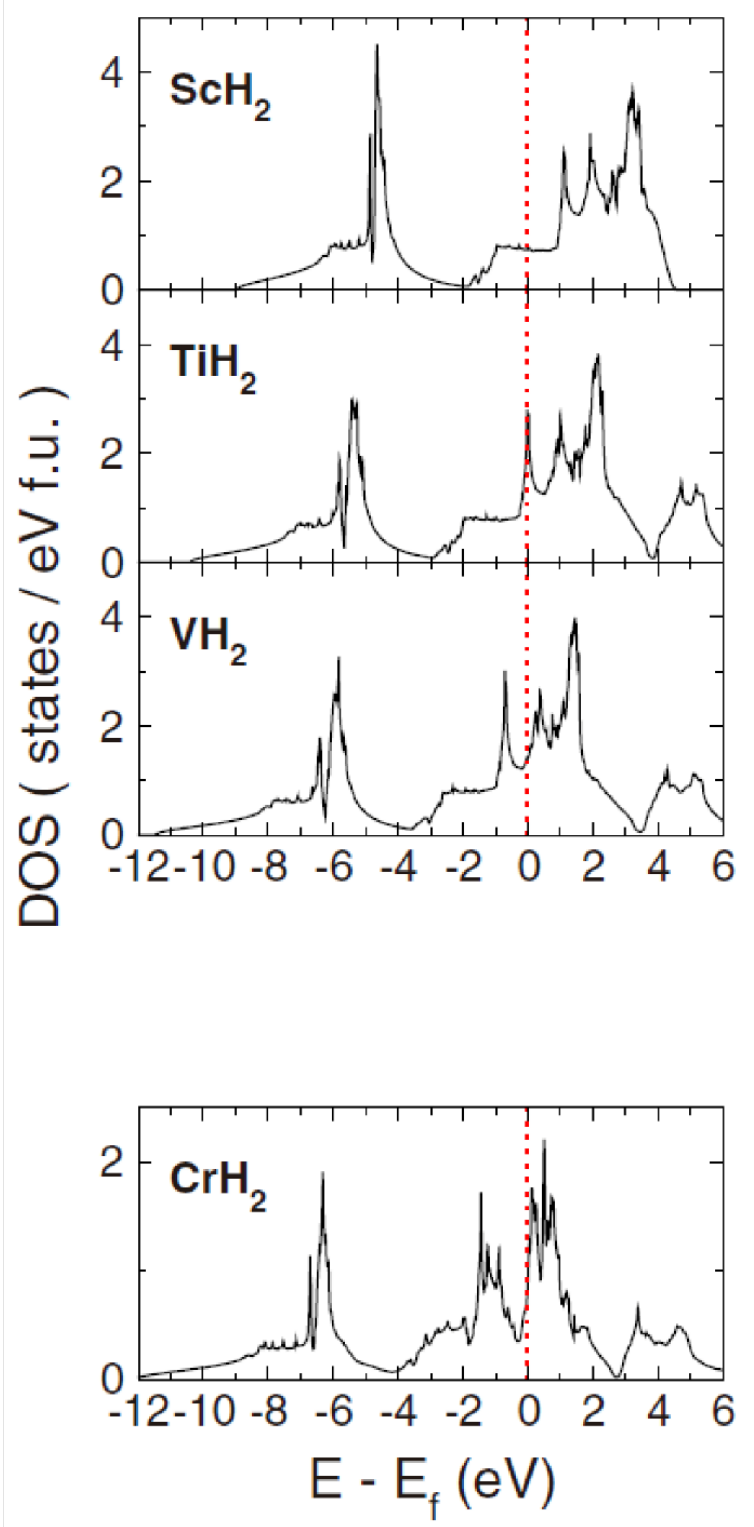
Figure 31. DOS of TMH 2 for TM = Sc, Ti, V, and Cr. For CrH 2 , the nonmagnetic DOS is given. Reproduced with permission [25]. Copyright 2009, American Physical